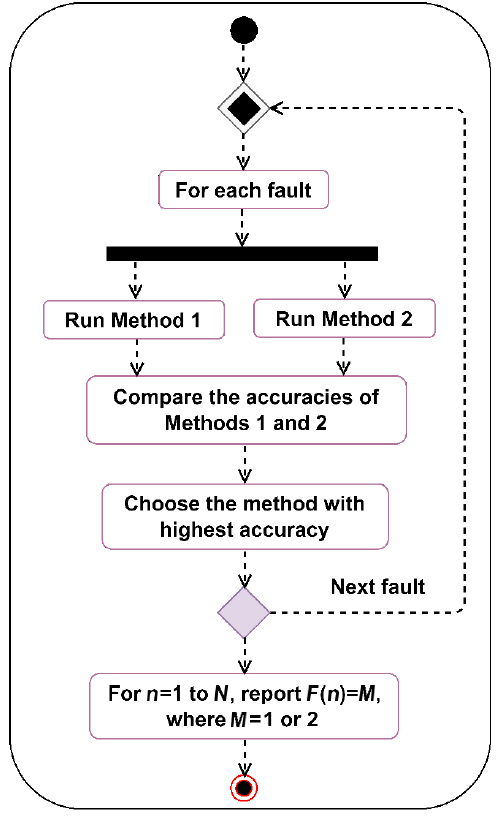
Fig. 5 Tradeoff method, N is number of faults an M is either Method 1 or 2.